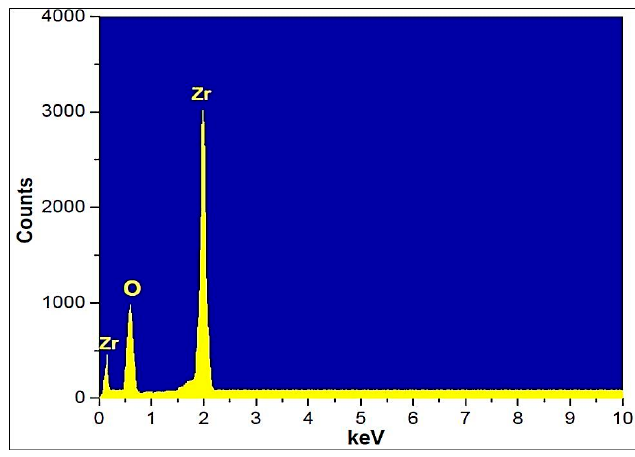
Figure 4. EDS of ZrO 2 NPs.